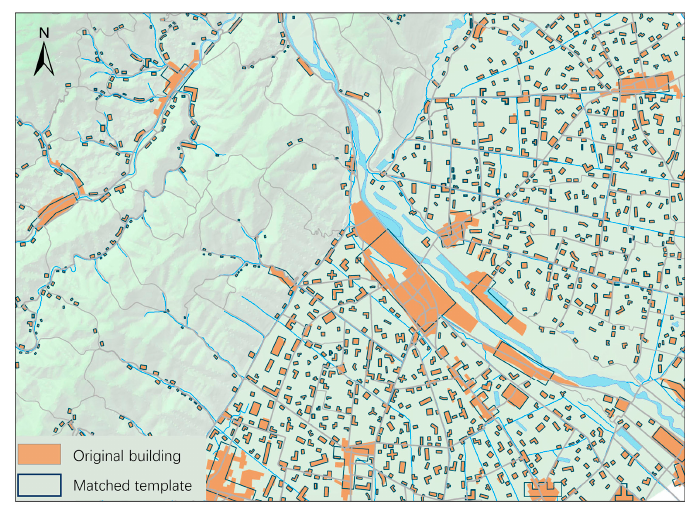
Figure 7. An extra experiment to test the scattered houses in a medium-small scale map.